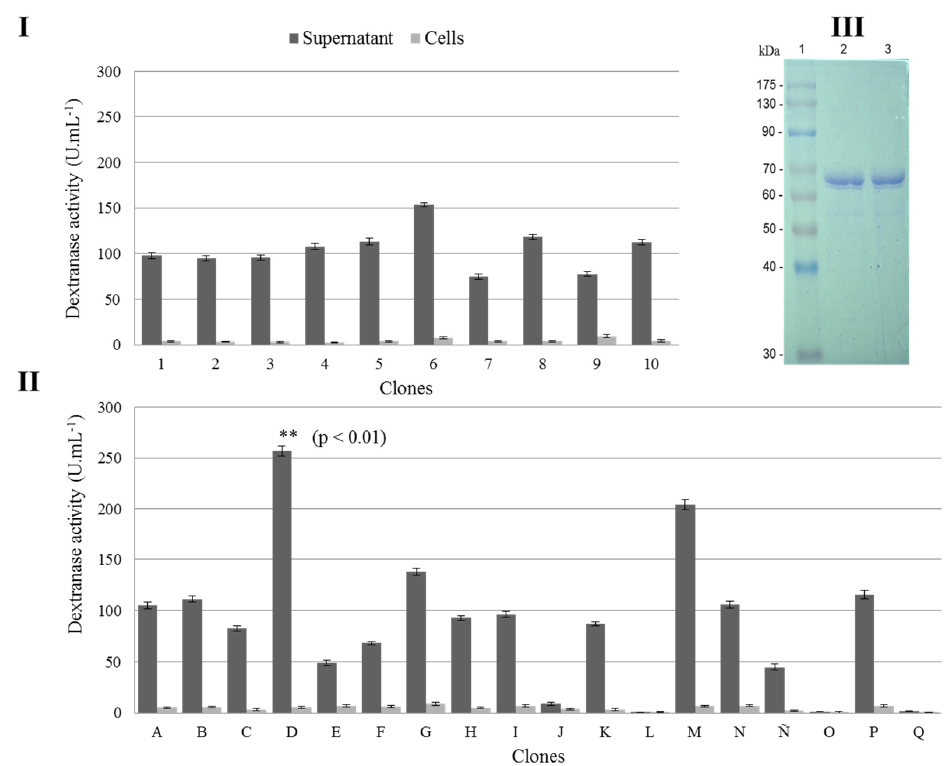
Figure 2. Detection of r – Tm DEX49A– ∆ SP– ∆ N30 production in recombinant K. phaffii clones. Secreted and cell-associated dextranase levels ( I and II , respectively) of 28 different clones (1–10) and (A–Q). Dextranase levels of different clones are normalized to the biomass (OD). ( III ): SDS – PAGE of the culture supernatant of clones D (2) and M (3) stained with Coomassie Brilliant Blue R-250, (1) molecular weight standard PiNK Prestained Protein Ladder (NIPPON Genetics Europe, Germany). (**) refers to highly significant differences ( p < 0.001) between clone D and the other clones. Significance (or p value) was obtained by applying the Student’s test.